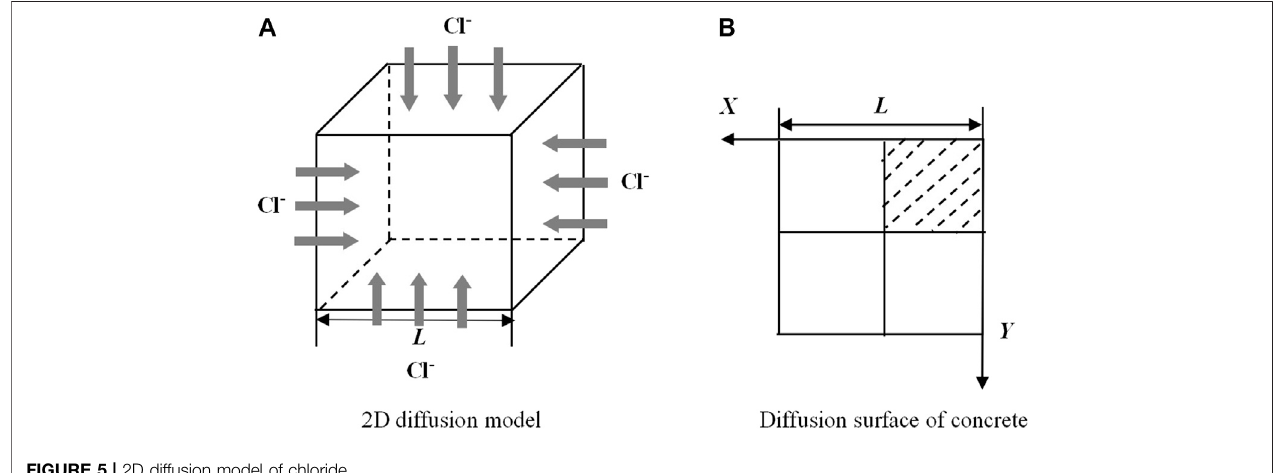
FIGURE 5 | 2D diffusion model of